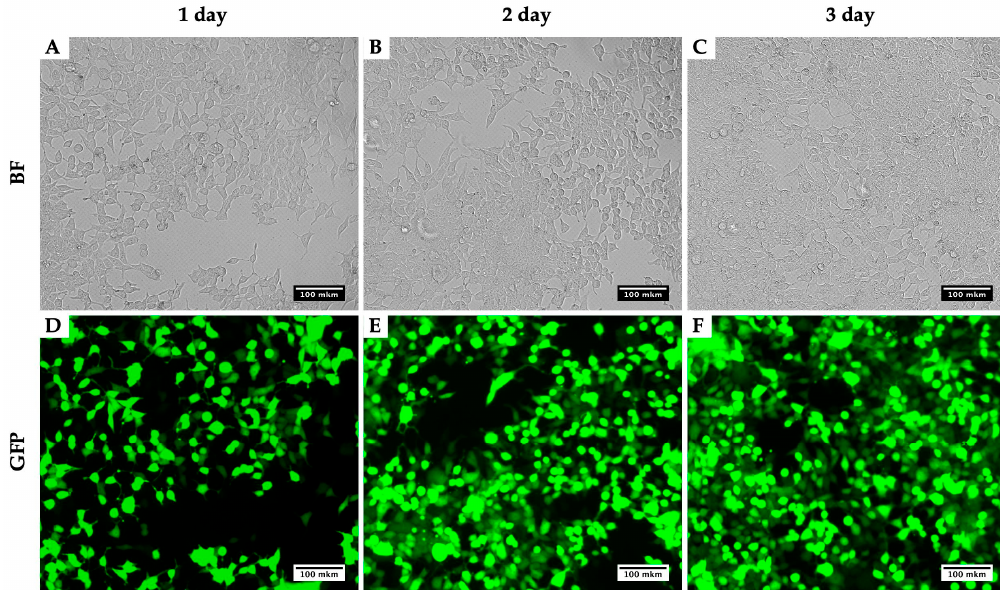
Figure 2. Dynamics of GFP signal accumulation in HEK293T within three days during the